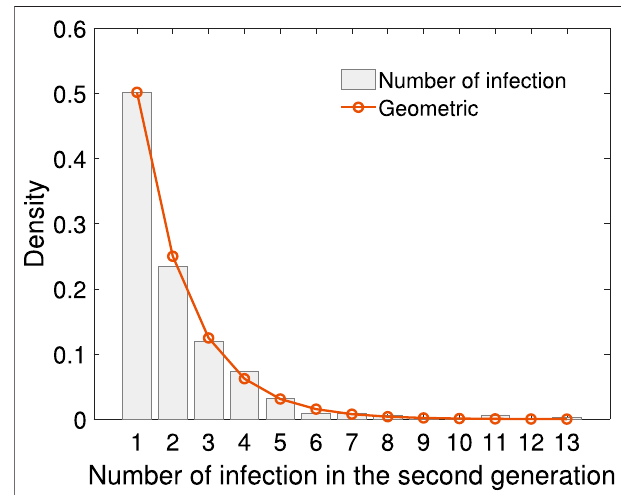
FIGURE5| Theempirical distribution ofinfectionnumbersinthesecond generation with geometric fi tting. The geometric distribution law is P ( k secondarycases ) (cid:1) p ( 1 − p ) k − 1 for k ≥ 1. The parameter is p (cid:1) 0 . 50, and the K – S test value is